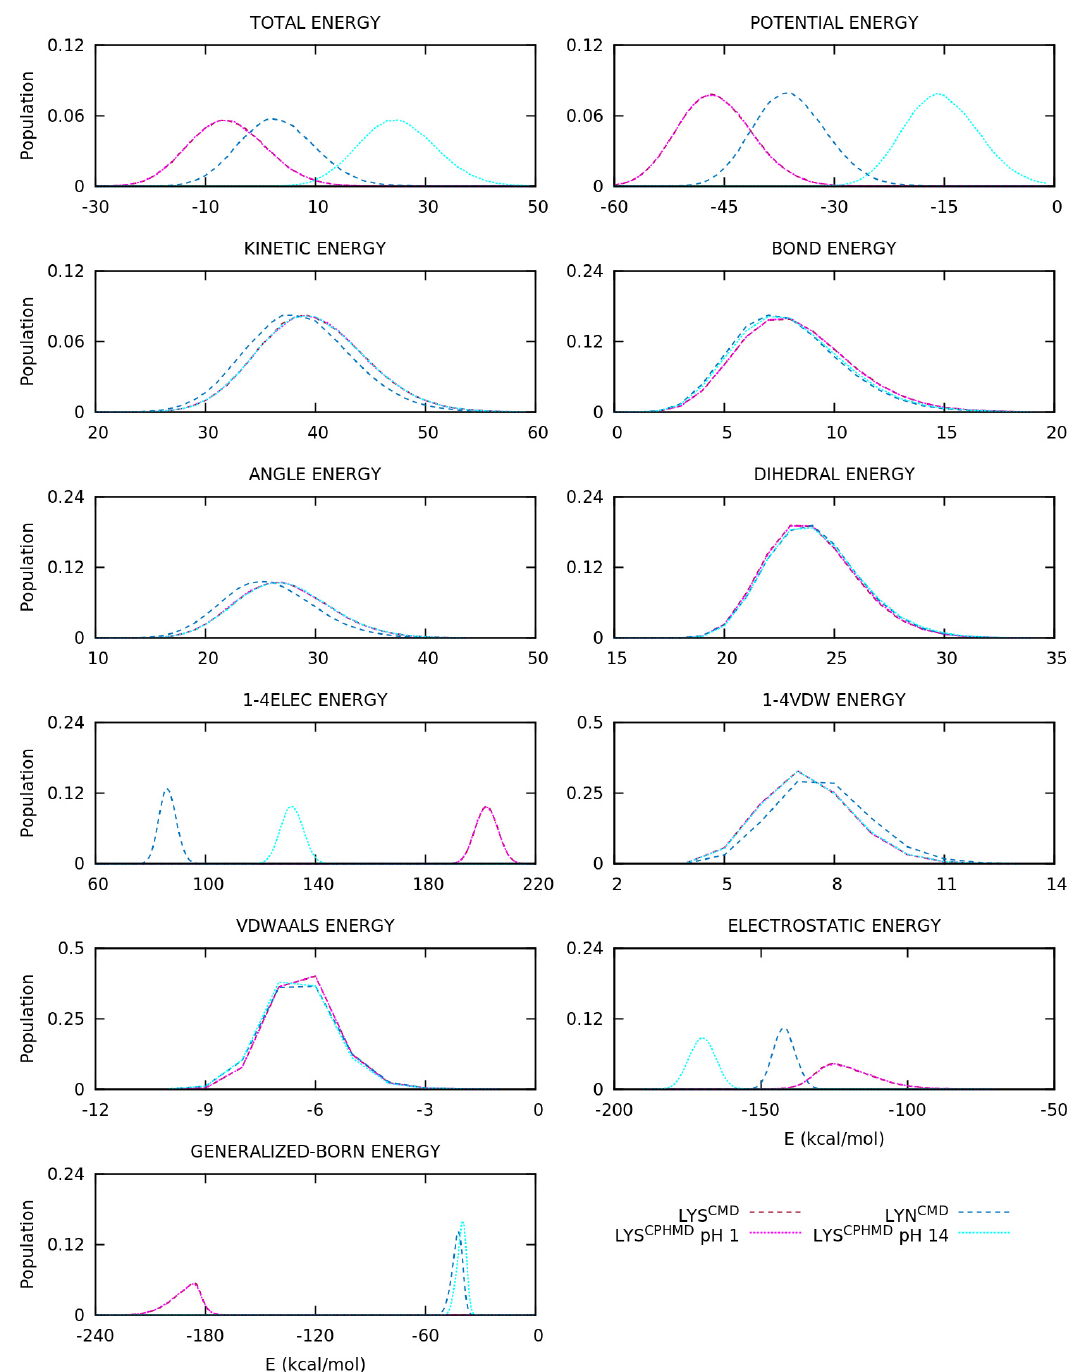
Figure 7. Energy distributions of the blocked Lys 2 tripeptide. Global, inner, van der Waals, and electrostatics terms are illustrated. Dotted and dashed lines are CPHMD and CMD simulation methods, respectively.